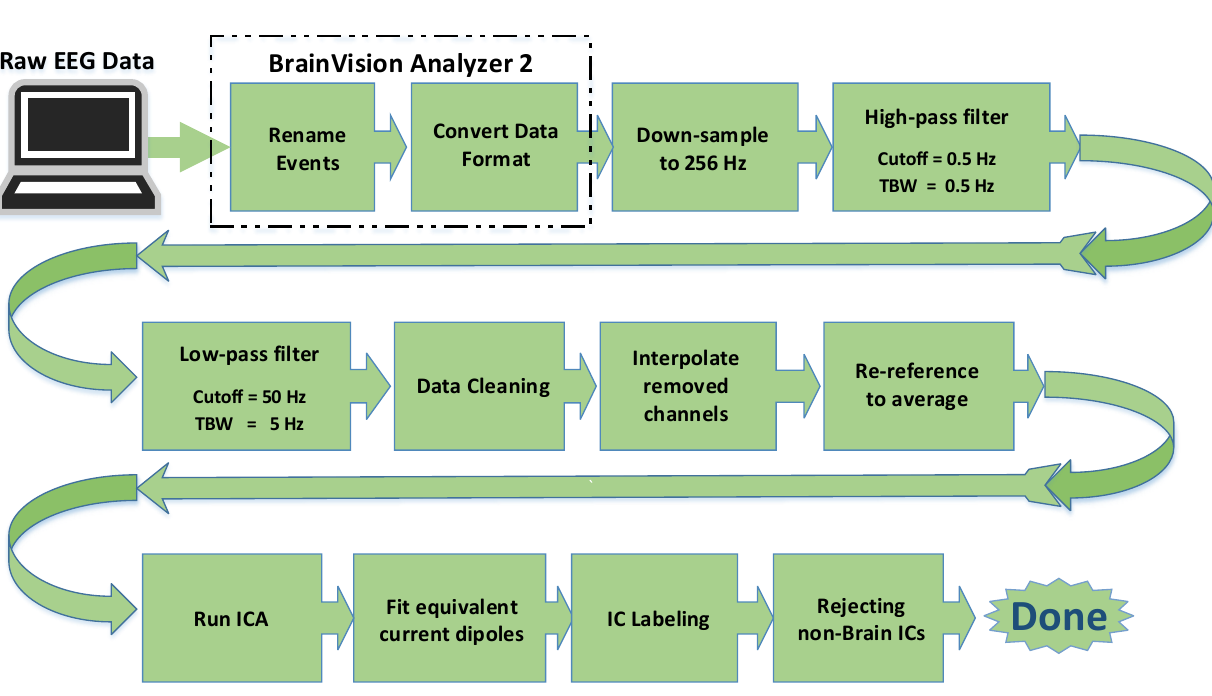
Figure 3. EEG data preprocessing pipeline. The first two steps are done using BrainVision Analyzer 2, while the other steps are performed on MATLAB